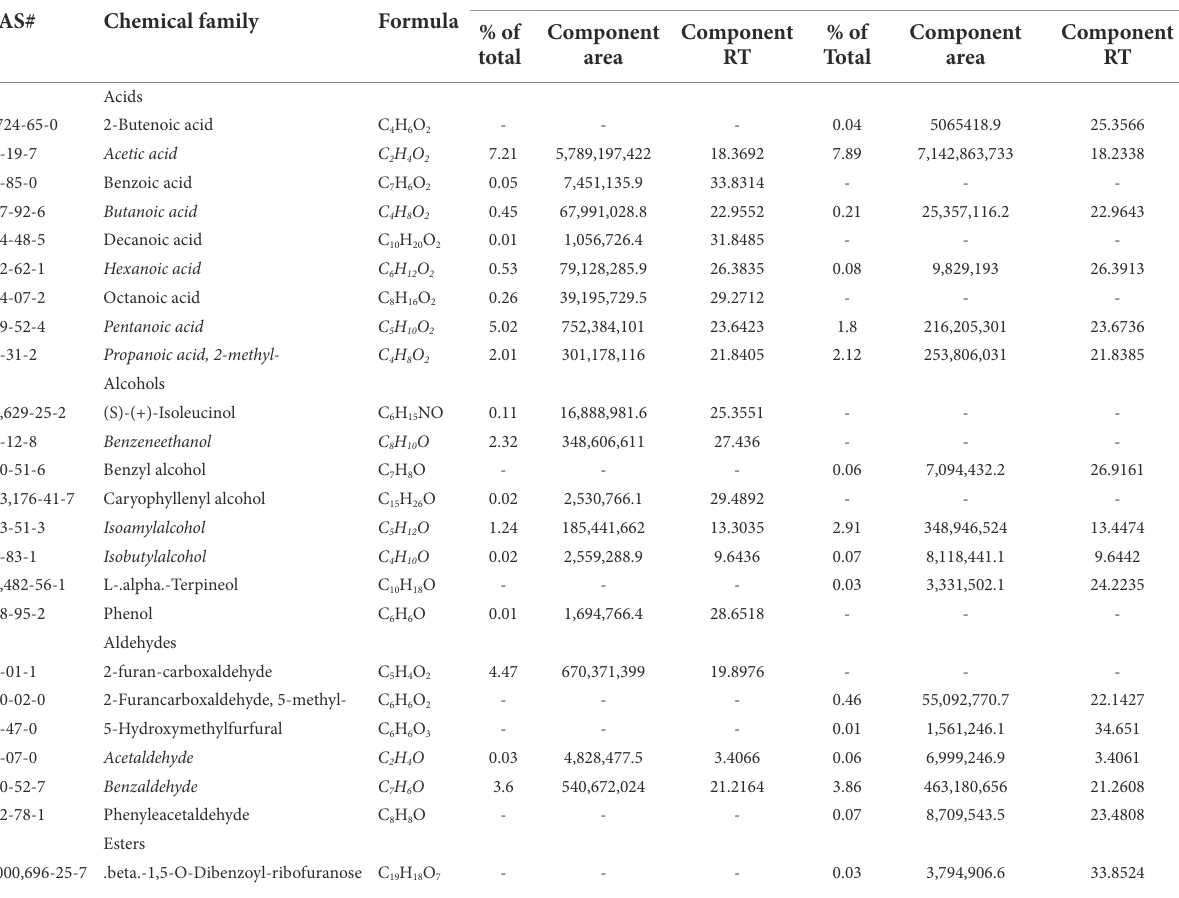
TABLE 2 VOCs composition in samples obtained from P. azoreducens P8 and A. aceti WK acetification.